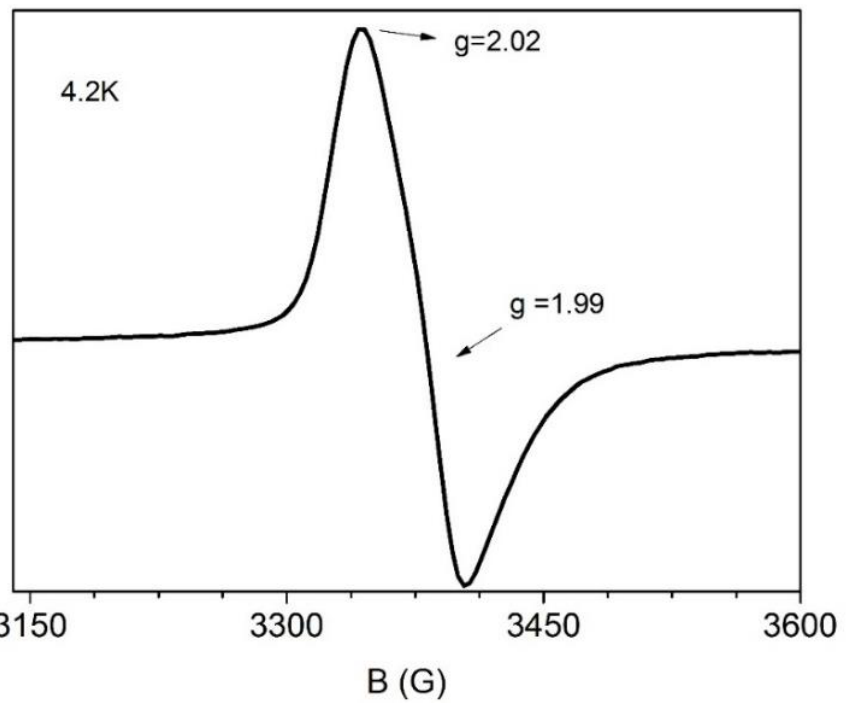
Figure 6. X-band EPR spectrum from a powder sample of 2 at 4.2 K. EPR conditions: modulation